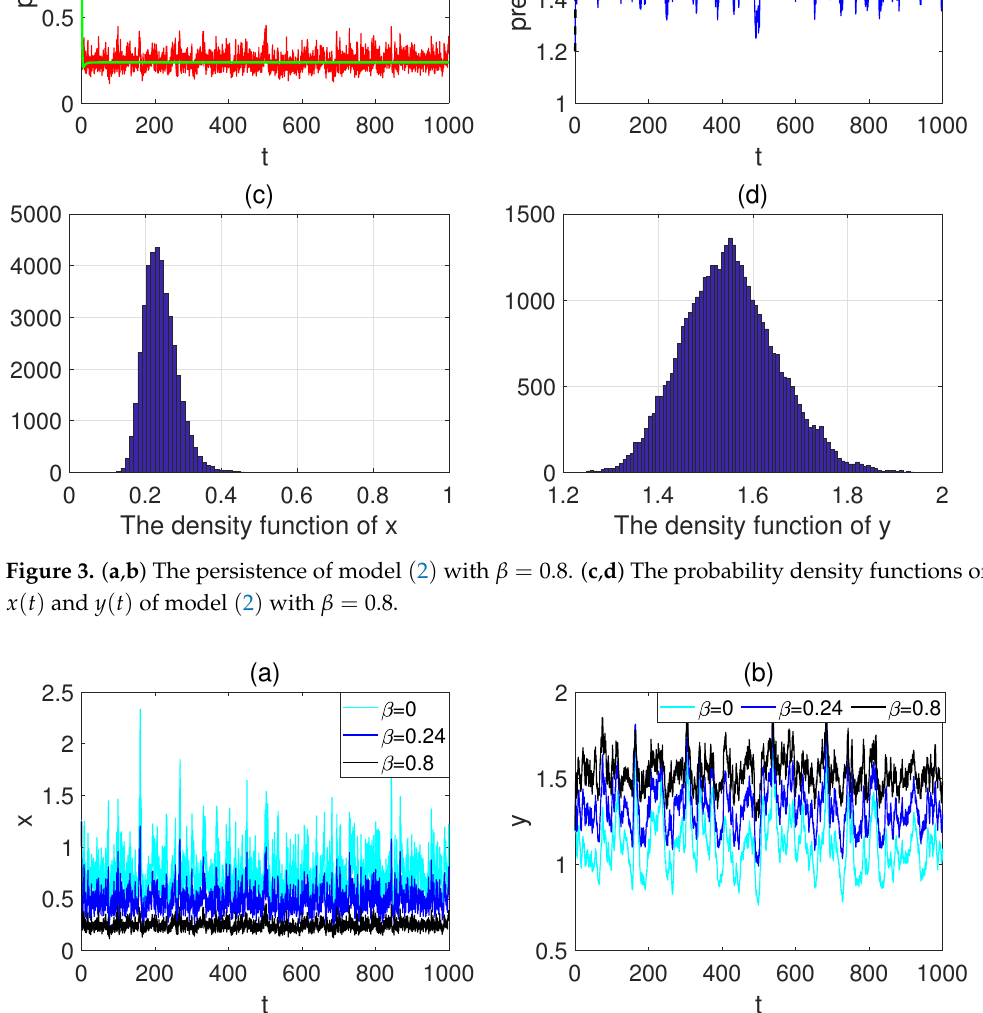
Figure 4. ( a , b ) The trajectories of x ( t ) and y ( t ) for model ( 2 ) with different hunting cooperation coef-